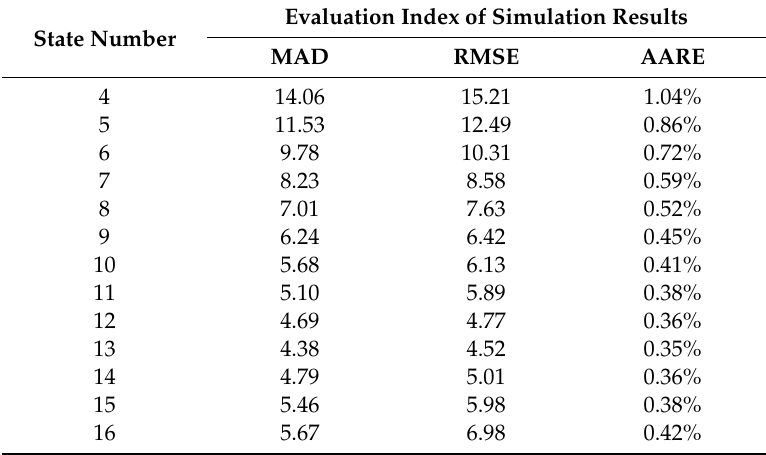
Table 2. Simulation results of MC model with four states to 16